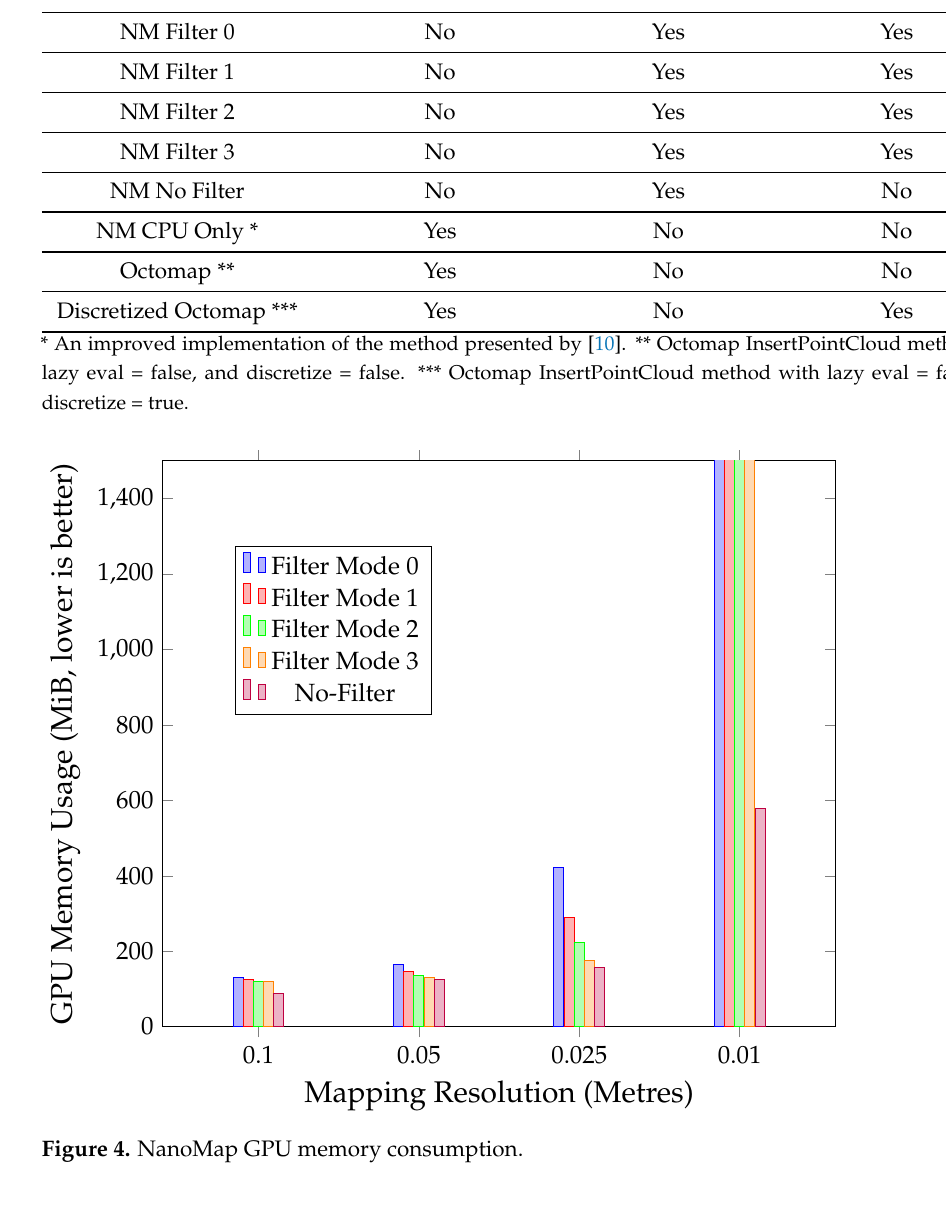
Table 2 outlines the methods tested and their key features. The benchmarks were each run 10 times with a target grid resolution of 0.1 m, 0.05 m, 0.025 m, and 0.01 m on the laptop, and 0.1 m, 0.05 m and 0.025 m on the Jetson Nano device. Figure 4 and Table 3